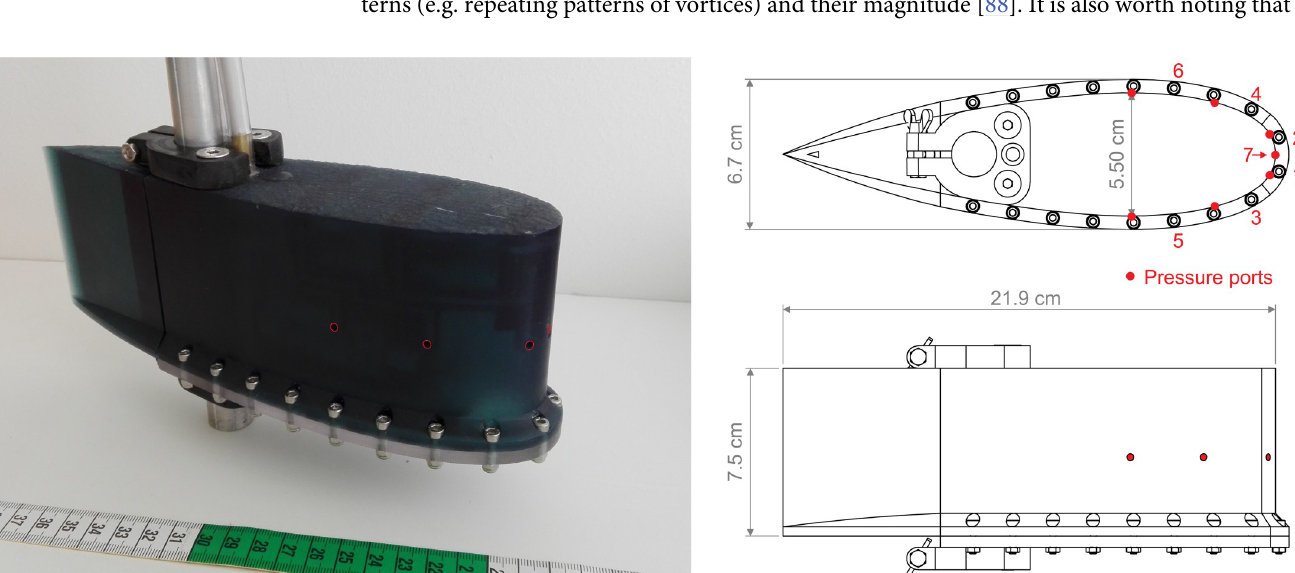
PLOS ONE | https://doi.org/10.1371/journal.pone.0211115 January 23,